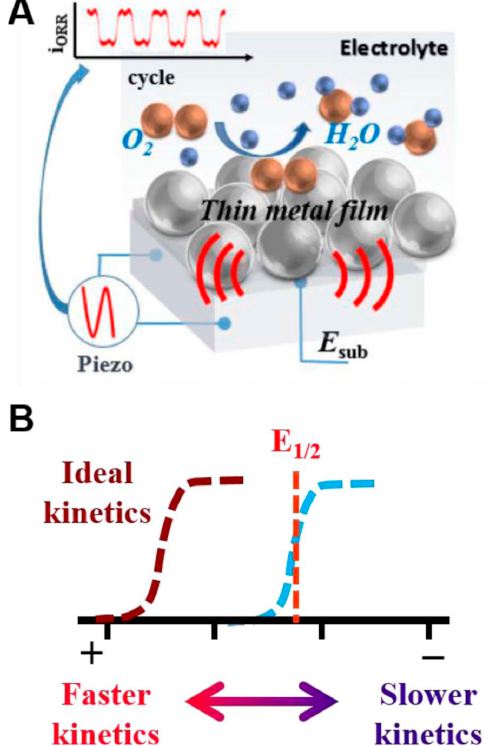
Figure 8. Action of a piezoelectric substrate on the reactivity of the ORR on platinum. ( A ) Piezoelectric control of platinum strain determines oxygen reduction reactivity. ( B ) Theoretical steady state voltammetric response of the ORR when changing the reaction kinetics with piezoelectric actuation. Shifts toward more positive potentials indicate increased kinetics, while shifts toward negative potentials indicate more decreased kinetics. The ideal ORR wave would have its half-wave potential at 1.23 V vs. NHE [64].